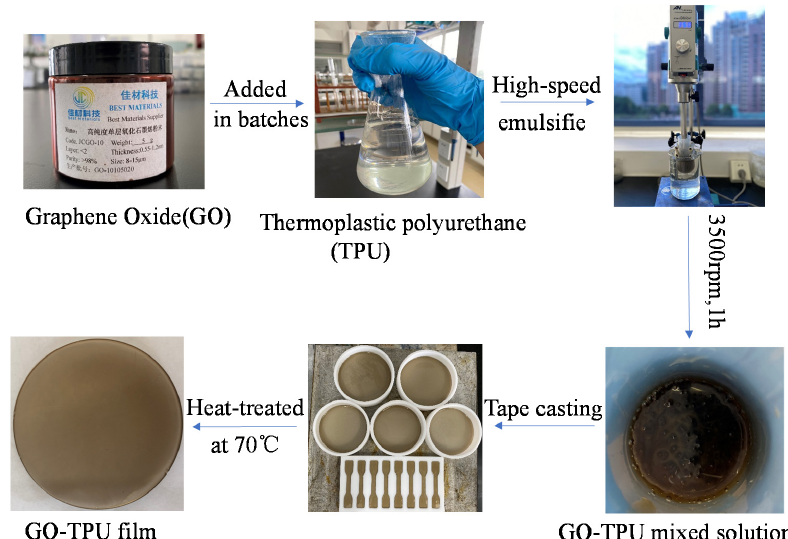
Figure 1. Schematic diagram of the fabrication process of graphene oxide-thermoplastic polyurethane (GO-TPU) composite film.